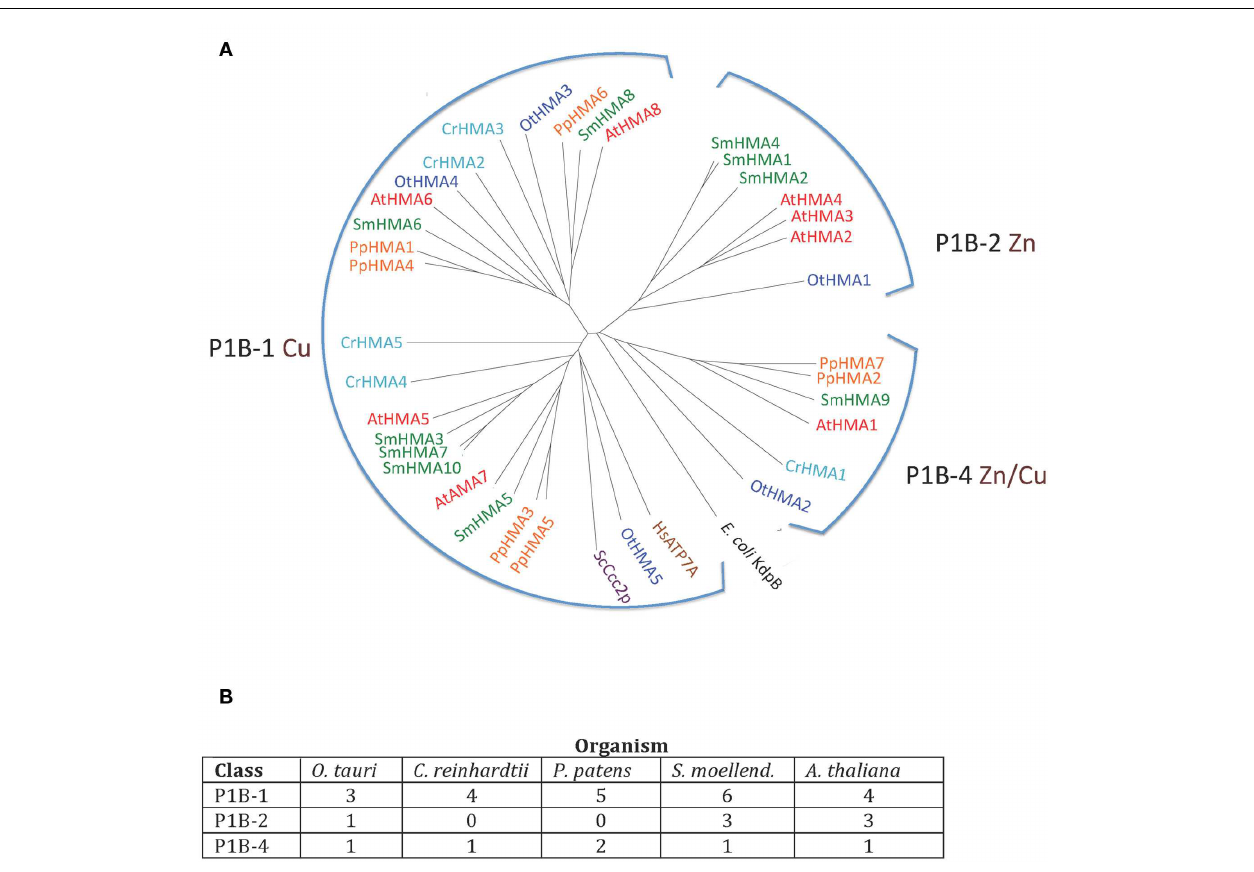
KdpB (P03960), and HsATP7A (Q04656), and ScCcc2p (P38995), Cu + pumps from H. sapiens and S. cerevisiae , respectively. (B) Numbers of P1B ATPases by subgroups (Argüello et al., 2007) in the five plant genomes